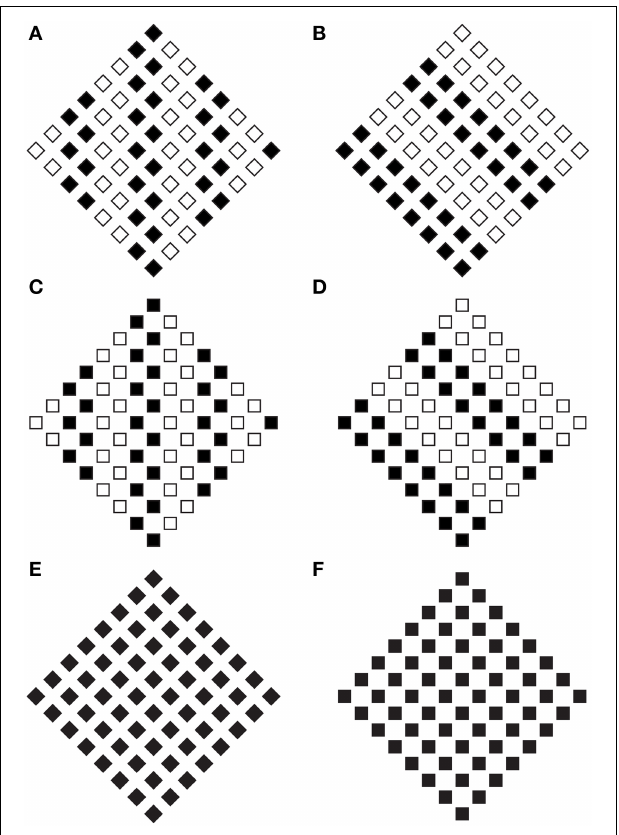
FIGURE 3 | The grouping by similarity induces the directional organization that induces diamonds and rotated squares in the same geometrical patterns. For further details please see the